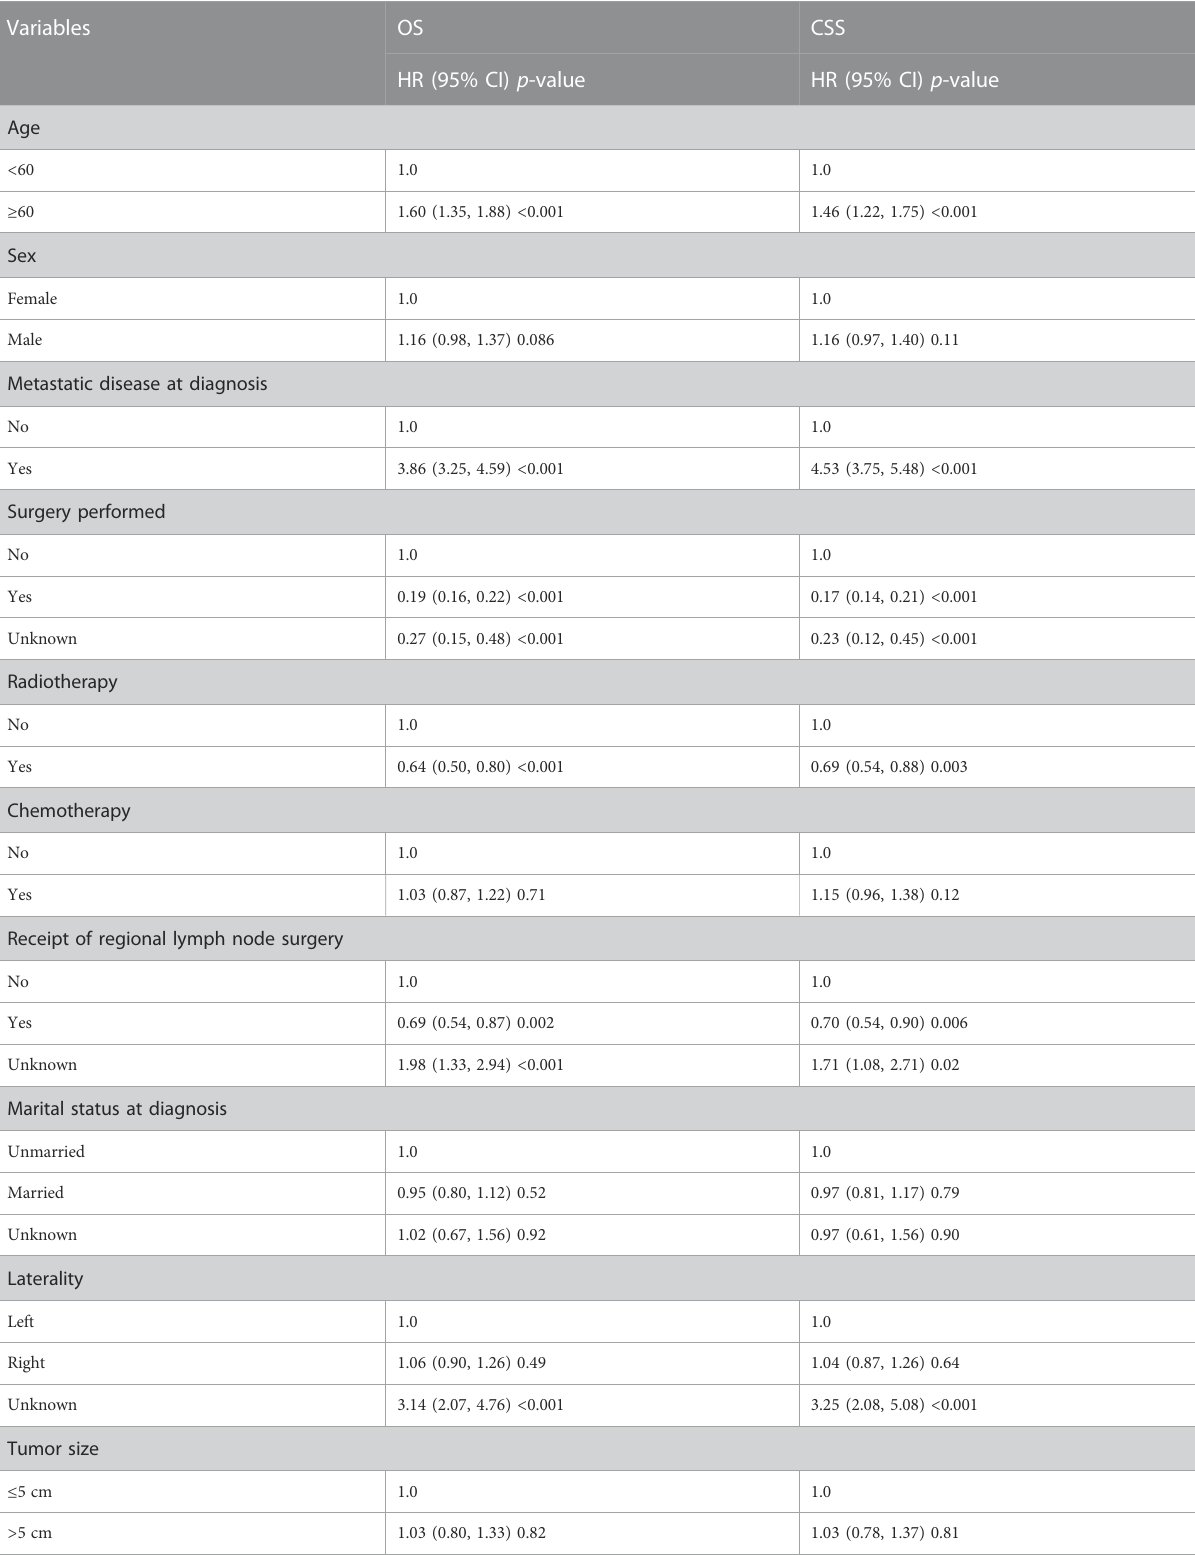
TABLE 2 Univariate analysis of affecting overall and cancer speci fi c survival of ACC